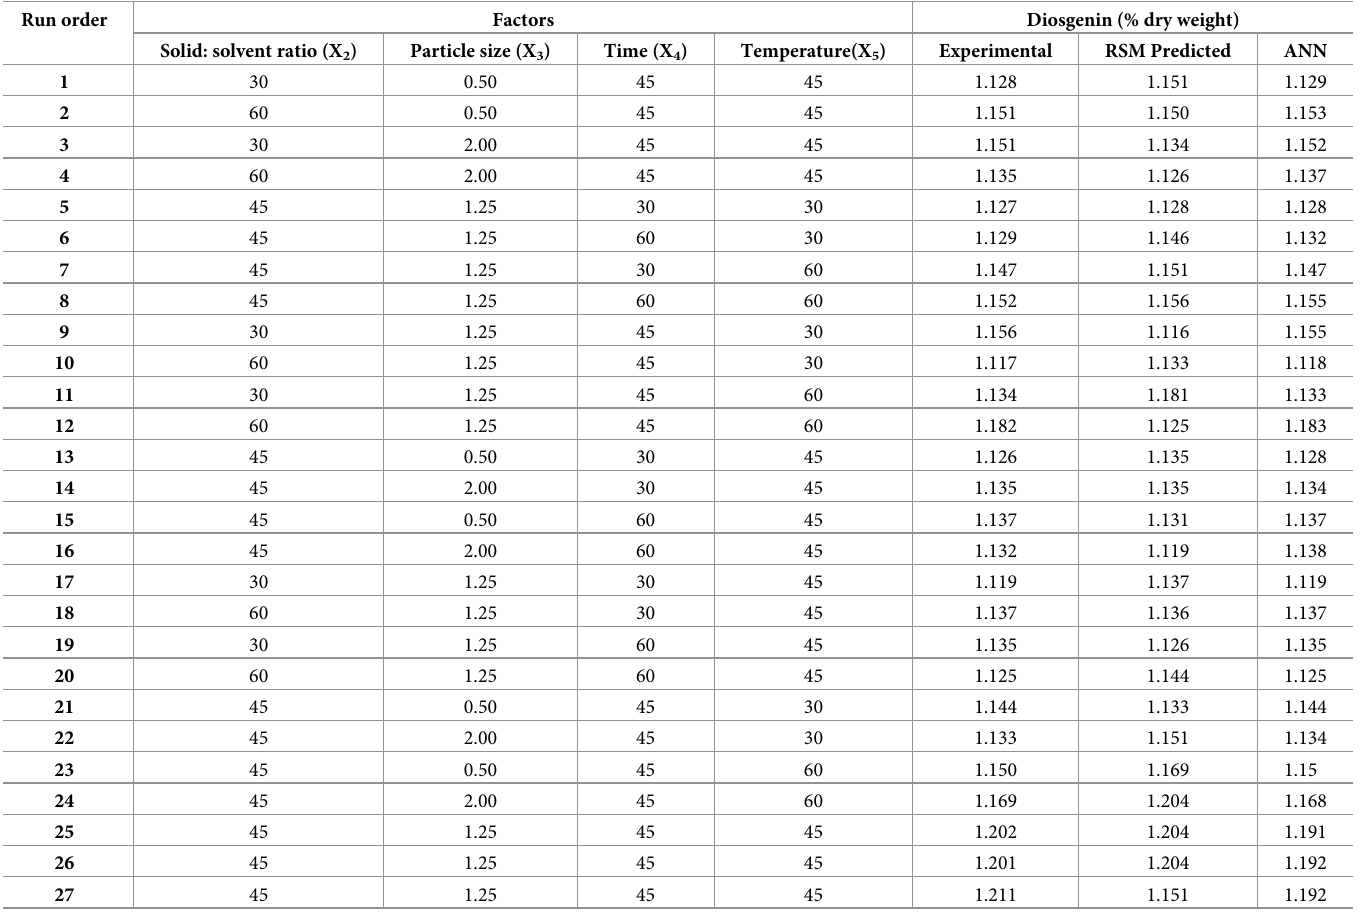
Table 6. Experimental and predicted value of BBD design with four different extraction variables: Solid: Solvent ratio(X 2 ), particle size (X 3 ), time (X 4 ) and tempera- ture(X 5